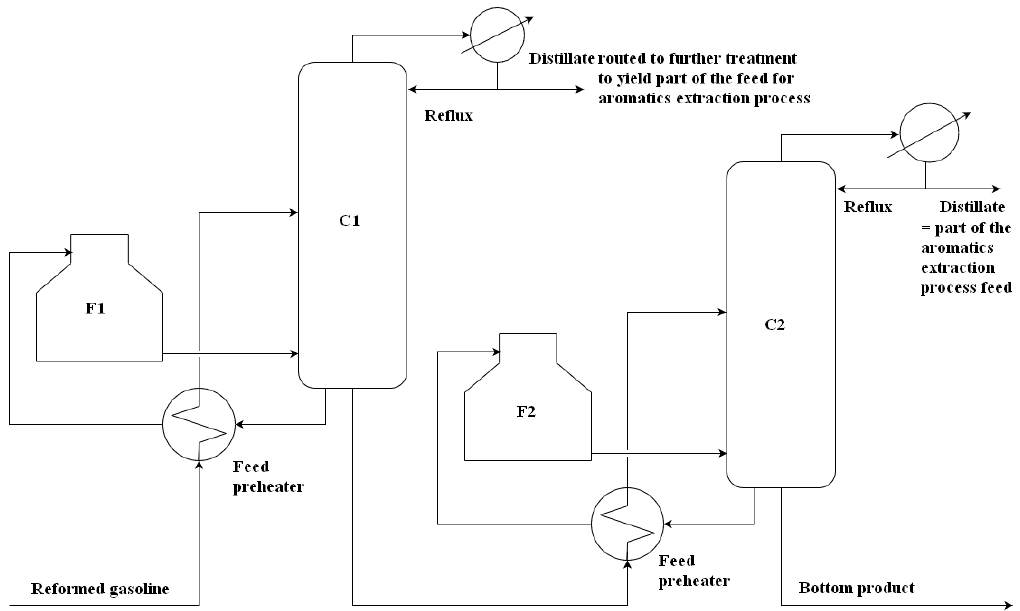
Table 1. Basic parameters of feed pretreatment columns.